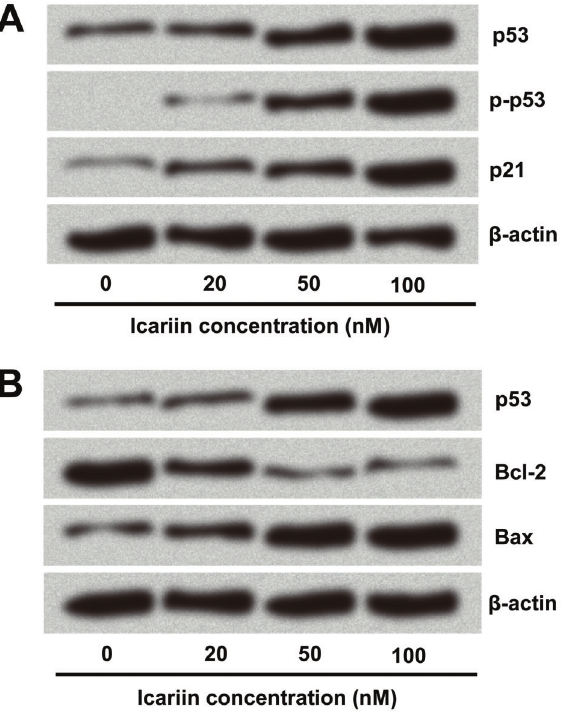
Figure 5. Effect of icariin on the cell growth-related proteins in colon carcinoma cells. The levels of p21 ( A ), Bcl-2, and Bax ( B ) expressions were detected by western blot. b -actin was used as internal